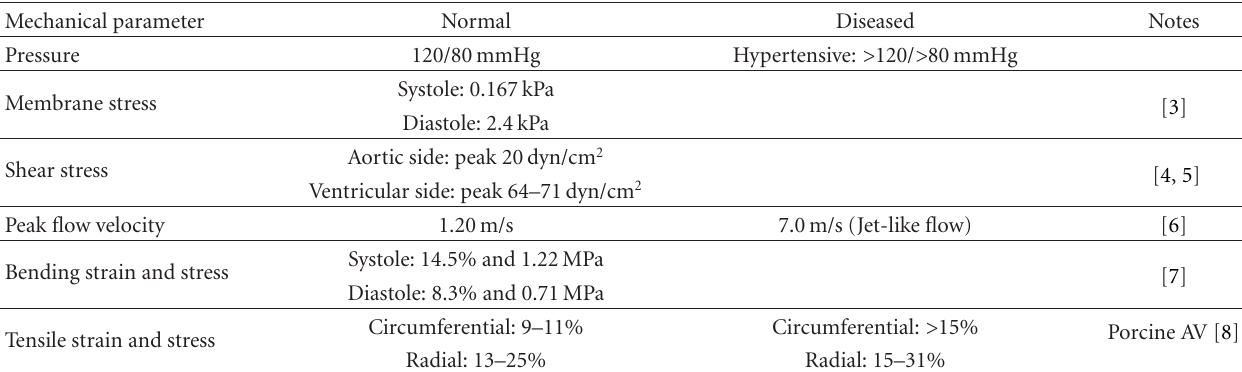
Table 1: Table outlining the current state of knowledge of valve hemodynamic/mechanical parameters. Knowledge of these parameters will aid the design of in vitro or ex vivo experimental studies to study mechanobiology. Mechanical